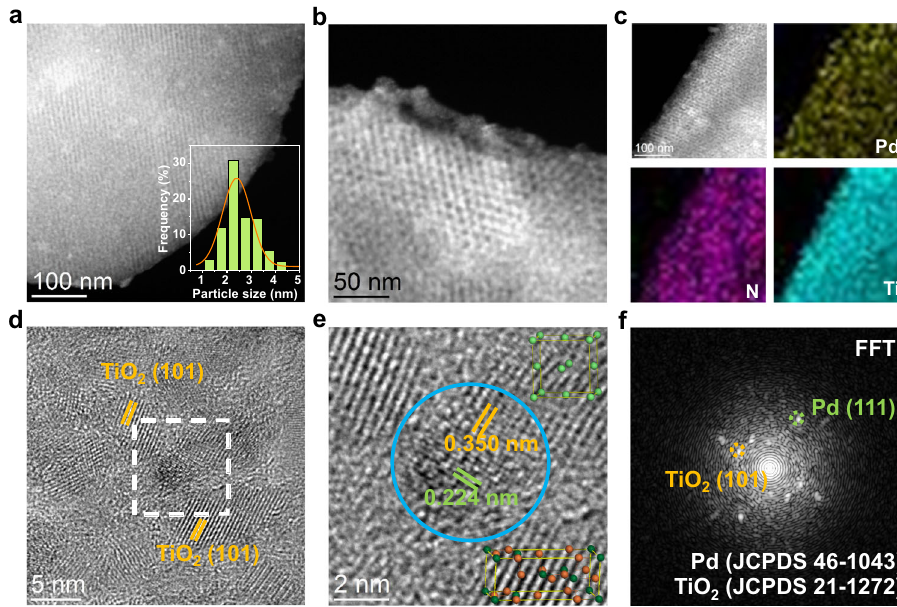
Fig. 1 Structure of Pd nanocatalysts. a, b Representative HAADF-STEM images for Pd/(N)TiO 2 -OMC and c the corresponding Pd, N and Ti elemental maps. The inset in a is the Pd particle size distribution which was determined from at least 200 nanoparticles. d HRTEM image of Pd/(N)TiO 2 -OMC. e Enlarged view of the white square in d . The top-right and bottom-right insets correspond to Pd and TiO 2 unit cells, respectively. f Selected-area FFT patterns of Pd and TiO 2 from the area in the blue circle in e